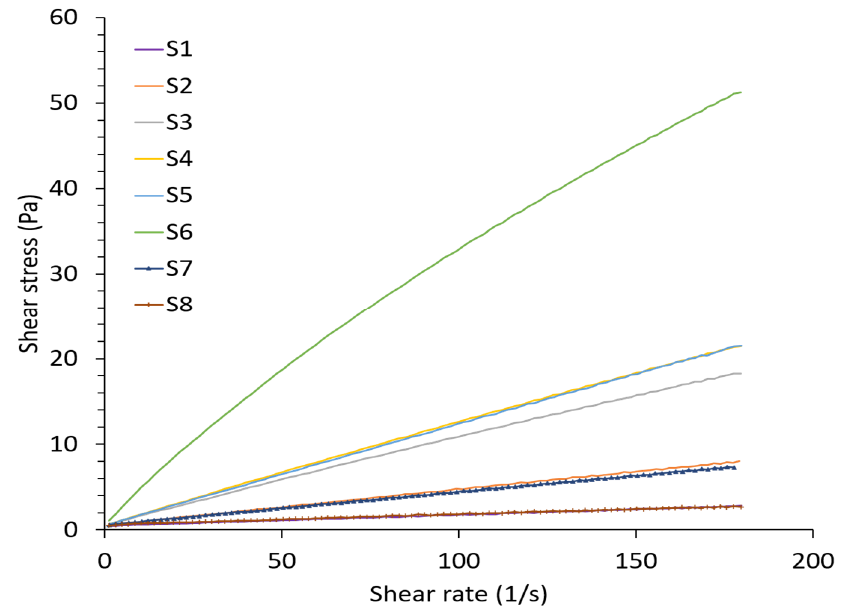
Figure 2. Scheme plot of shear stress versus shear rate of alginate solutions.